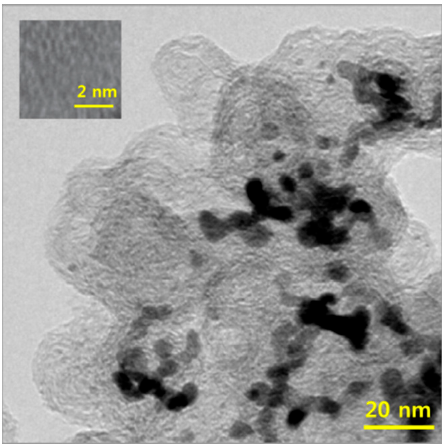
Figure 1. TEM image of carbon-supported Pt–BeO (the inset is the surface of Pt–BeO (1:11.5) on carbon support).